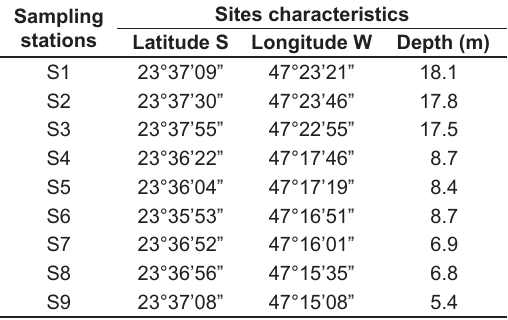
Table 1. Sampling stations (S) location and depth (m) at the Itupararanga reservoir (São Paulo State, Brazil). Sampling